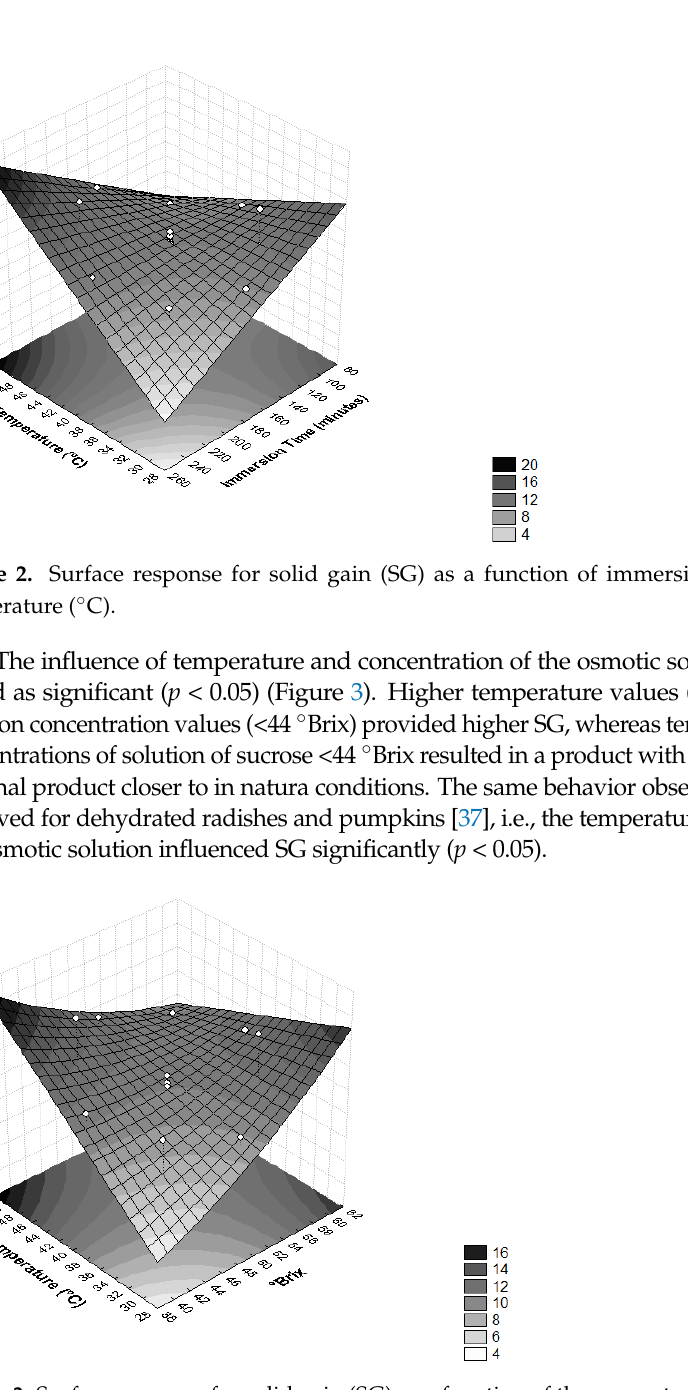
Figure 2. Surface response for solid gain (SG) as a function of immersion time (minutes) and temperature (°C).